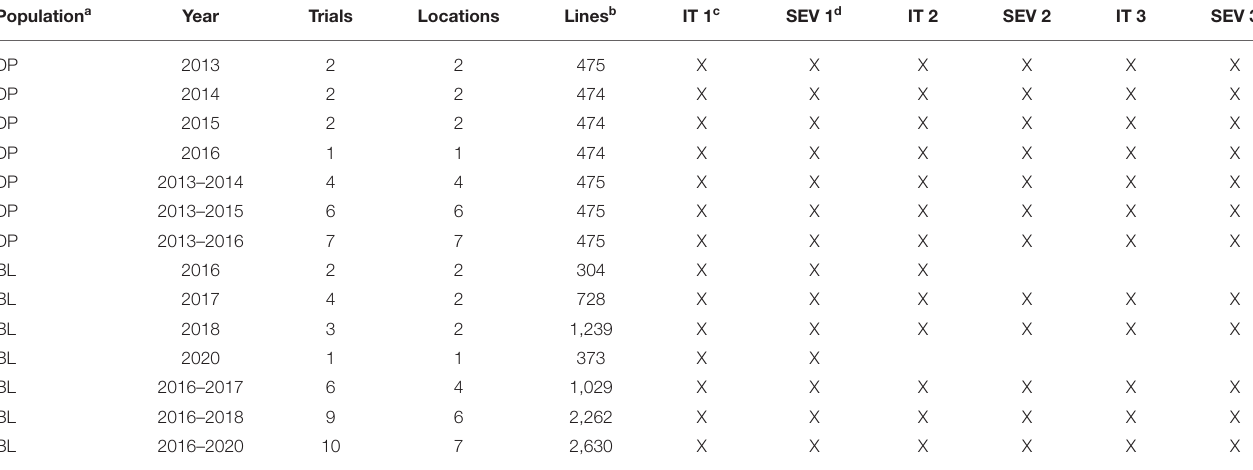
a DP, Diversity panel; BLs, Breeding lines. b Lines, Unique lines in the training population. c IT, Infection type. d SEV, Disease